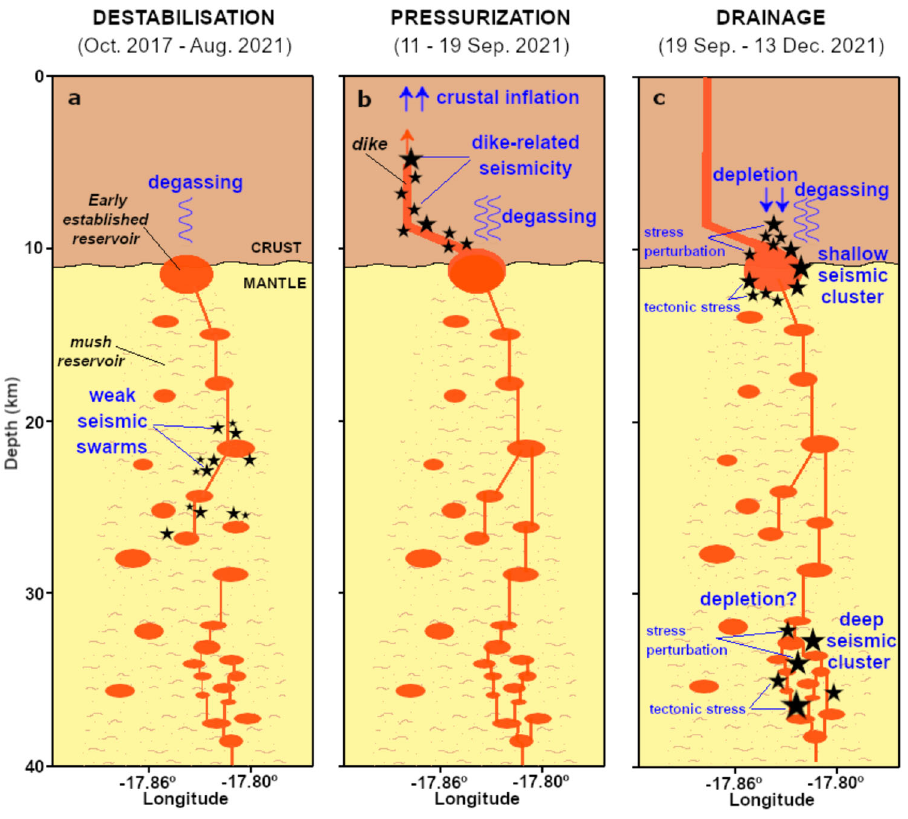
Fig. 6 | Interpretation of the reactivation process. Evolution of seismicity and magmatic plumbing at different stages: a from October 2021 to August 2021; b from 11 to 19 September 2021; c during the 2021 eruption. Drainage of the